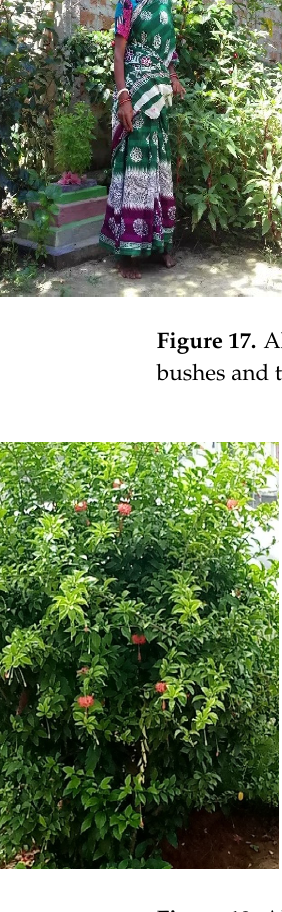
Figure 18. Alt-text: A lush green tree with bright red